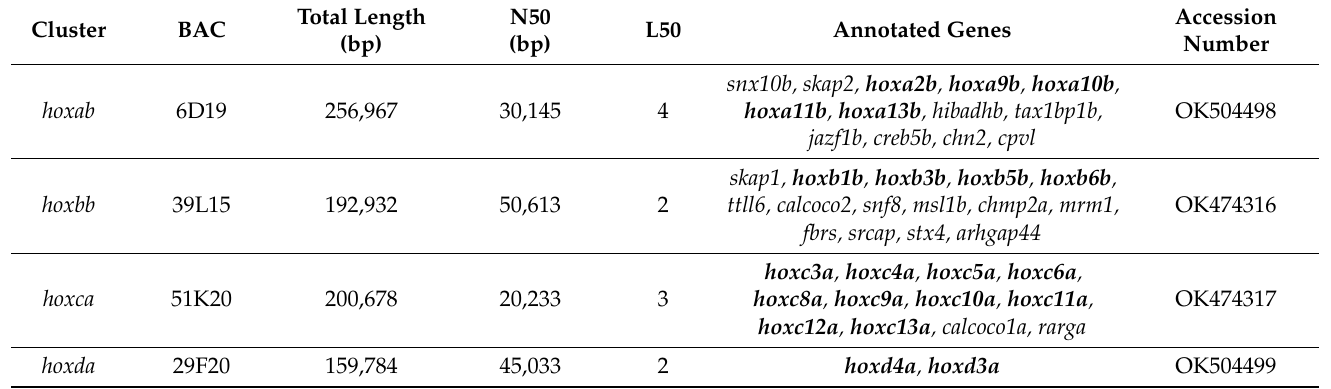
Table 3. Sequence and annotation data from the four hox -bearing BAC clones.